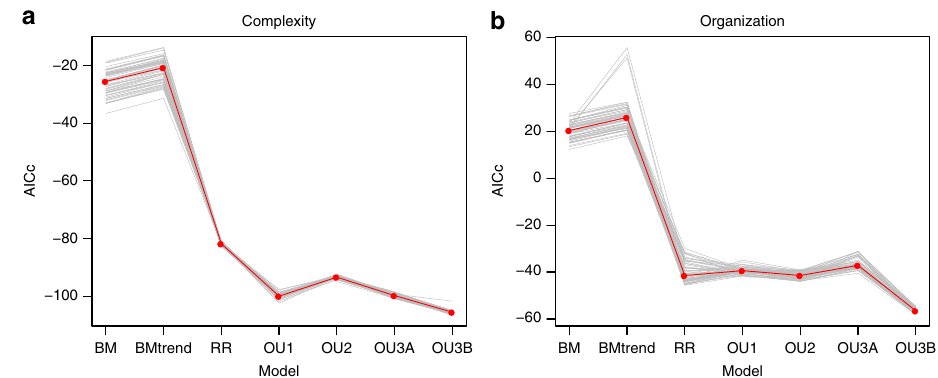
Fig. 4 Comparison of model performance based on AICc. Models compared across 60 trees for vertebral complexity ( a ) and organization ( b ). Results based on whole vertebra dataset. For model de fi nitions see Table 1. Source data are provided as a Source Data fi le Table 2 Relative fi t and rank order of evolutionary models for the whole vertebra (Fig. 5: blue curve) and alternate model (Fig. 5: red curve) and compares the observed likelihood ratio (Fig. 5: ertical line) to the alternate model distribution. If the jackknifed con fi dence intervals (Fig. 5: dotted line) on the LR lie outside of the 95% con fi dence interval for the null distribution (Fig. 5: shaded area) there is strong support for rejecting the null model.